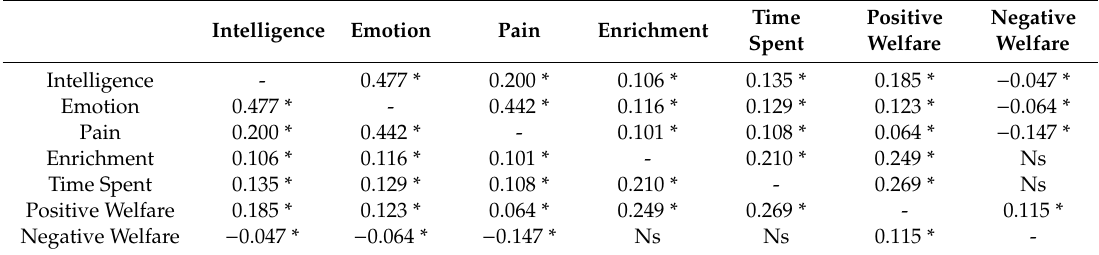
Table 4. Spearman’s Rho Correlation matrix ( n = 2126), Ns = p >